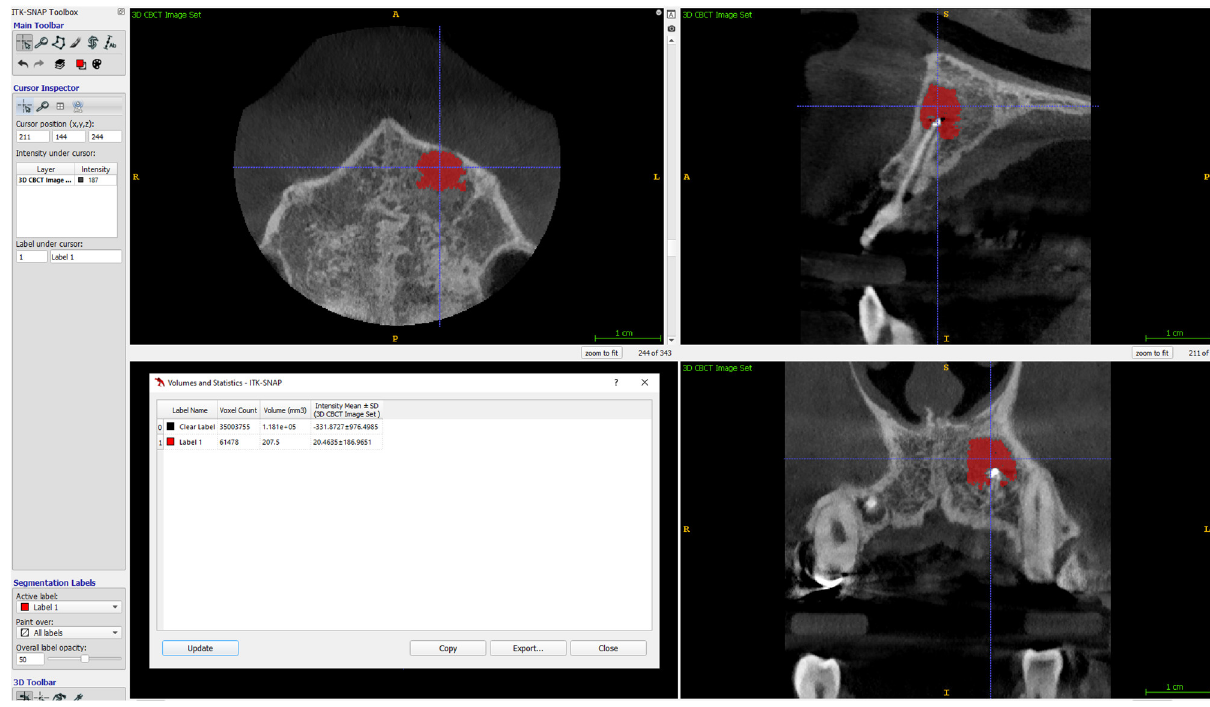
Figure 7. ITK-SNAP completed segmentation and visualisation of a lesion, with the volume result (after direct expression of the number of voxels and conversion into mm 3 ).